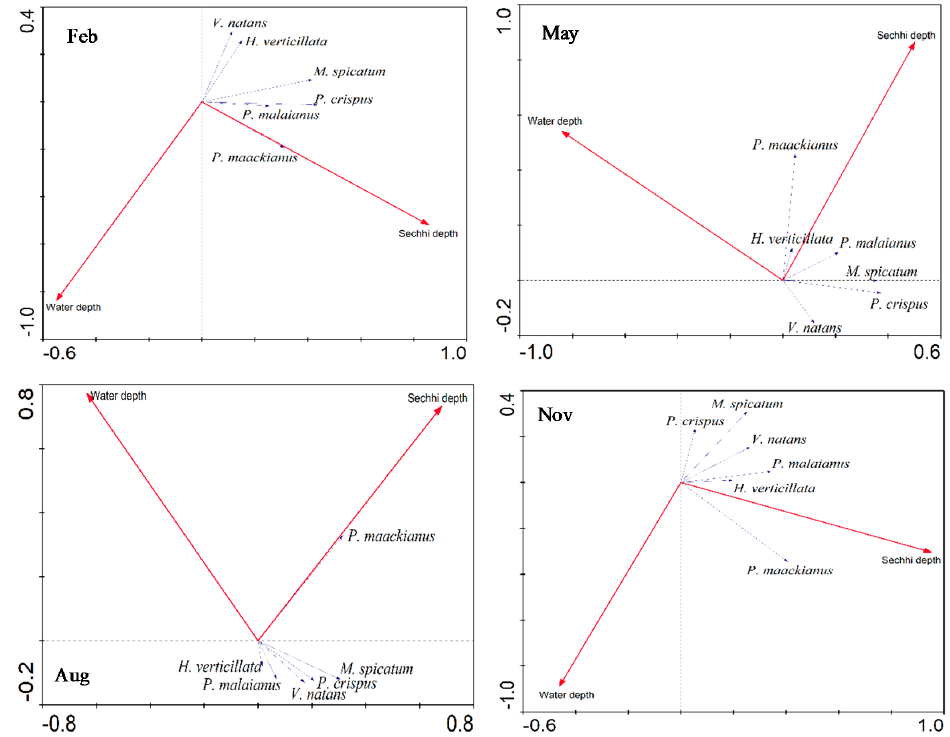
Figure 7. Redundancy analysis (RDA) of water depth and biomass of species collected in Lake Taihu from 2013 to 2017.